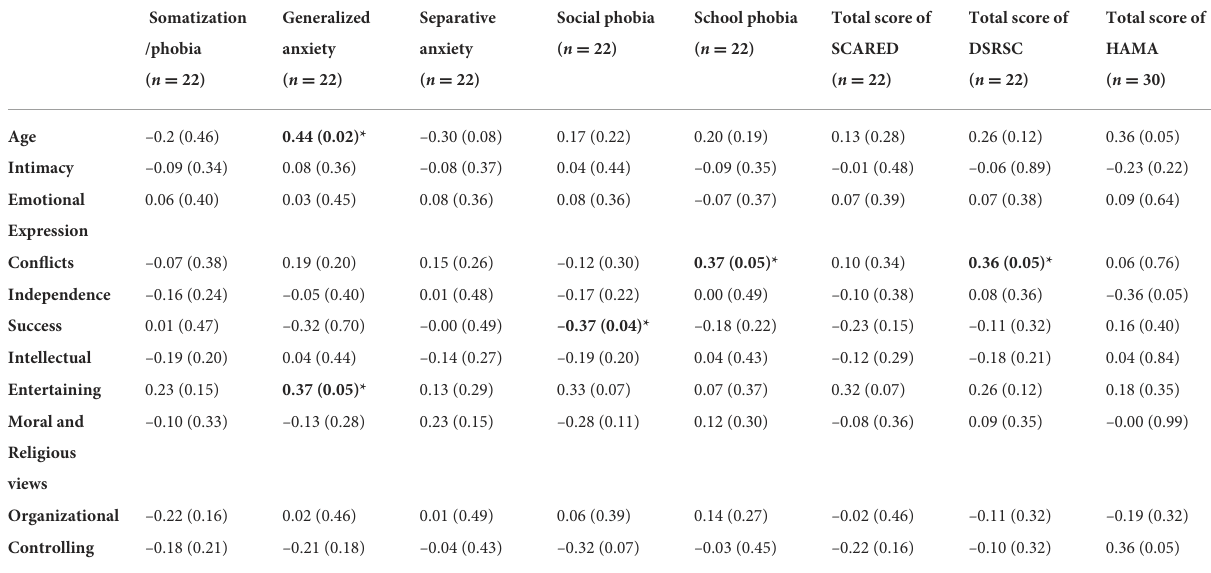
TABLE 2 Correlation analysis of anxiety and depression, age and the FES-CV in children with DSD. Somatization